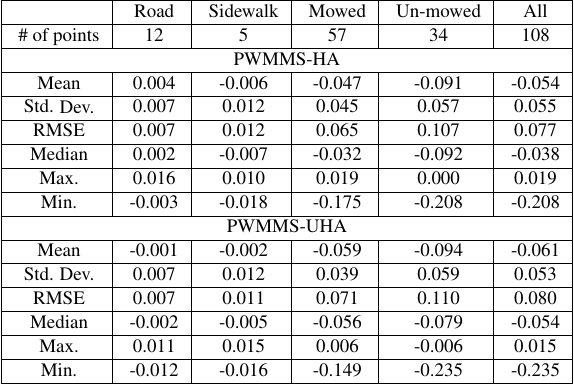
Table 1: Statistics of the elevation difference between RTK points and LiDAR points (unit: m) for the four cross-sections shown in Figure